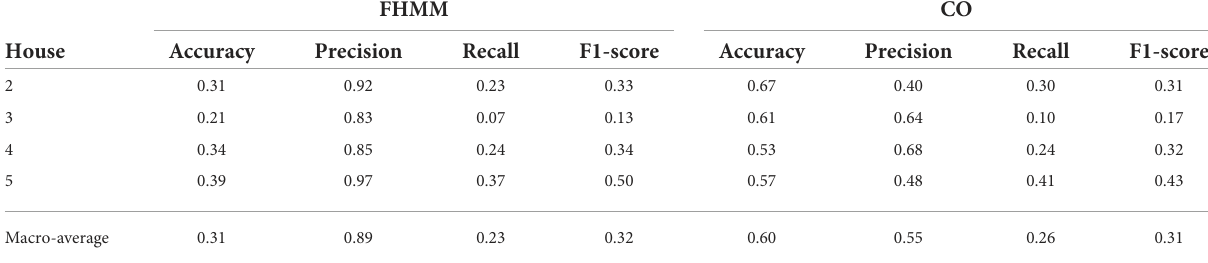
TABLE 4 NILM method performance in predicting the appliances’ on/off status per house and overall. House Accuracy Precision Recall F1-score Accuracy Precision